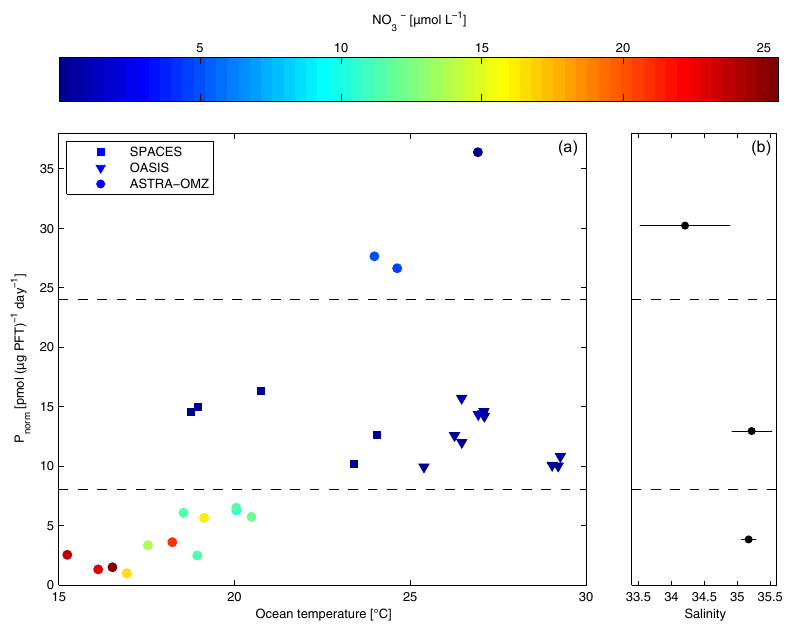
Figure 7. Left panel: relationship between P norm in pmol ( µgPFT ) − 1 day − 1 and ocean temperature in ◦ C during SPACES (squares), OASIS (triangles), and ASTRA-OMZ (circles) color-coded by NO − in µmolL − 1 . Right panel: mean salinity ( ± SD) of samples from left side plot 3 in each box divided by dashed lines.